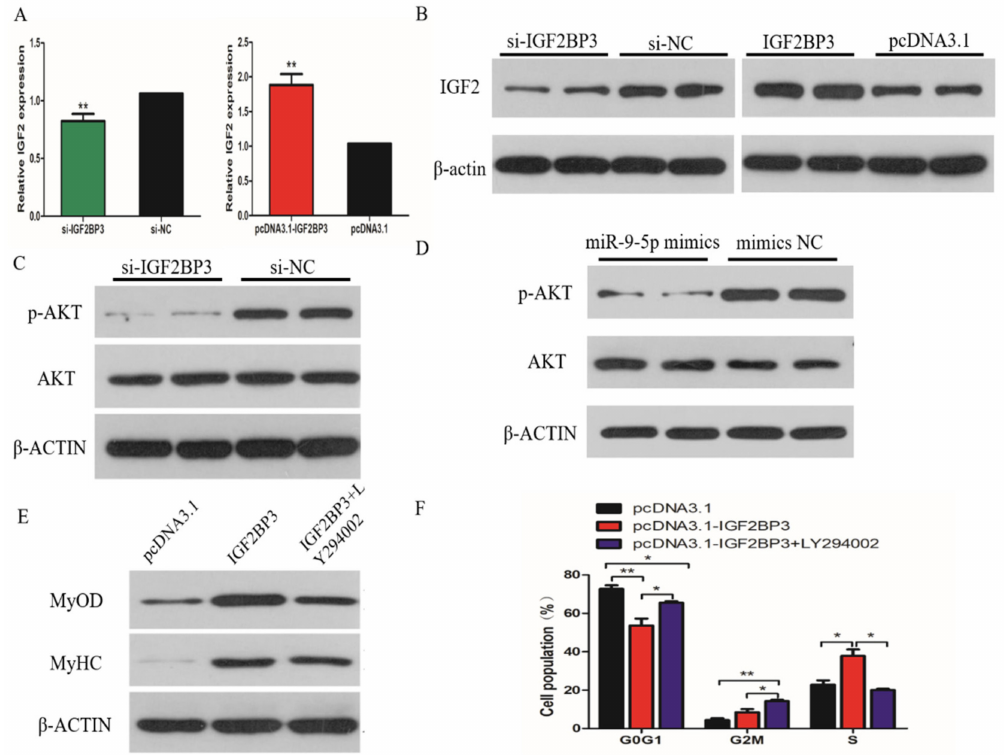
Figure 7. IGF2BP3 is involved in the IGF2-PI3K / Akt pathway. ( A , B ) The expression of IGF2 in SMSCs, following transfection of si-IGF2BP3, pcDNA3.1-IGF2BP3 or NC, determined by q-PCR and Western Blot. ( C , D ) The Western Blot results showing the levels of phosphor-Akt (p-Akt) and Akt in IGF2BP3-inhibited and miR-9-5p-overexpressed cells. ( E,F ) The e ff ect of pcDNA3.1-IGF2BP3 on the proliferation and di ff erentiation of SMSC cells in the absence or presence of LY294002. The data are expressed as mean ± SEM ( n = 6). * p < 0.05; ** p < 0.01 vs.